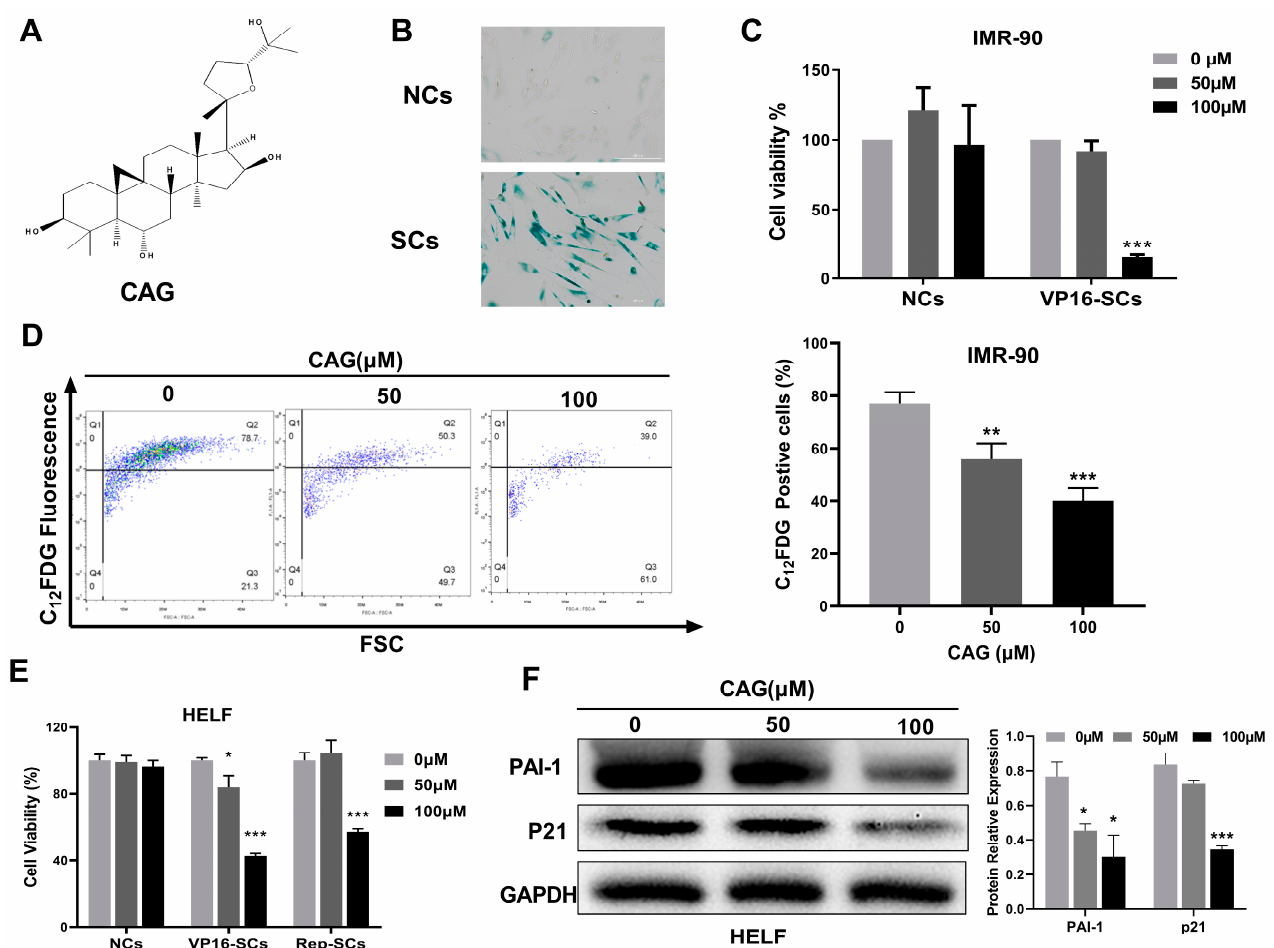
Figure 1. CAG is a potential broad-spectrum senolytic agent. ( A ) Chemical structure of CAG. ( B ) Representative images displaying SA- β -Gal staining after treatment of IMR-90 cells with 20 µM VP-16. Microscopic (magnification of 200 × ) images were taken. ( C ) Survival analysis of nonsenescent (NCs) and senescent IMR-90 cells (VP16-SCs) treated with CAG (at concentrations of 50 and 100 µ M, respectively). ( D ) Representative flow cytometric histogram showing detection of SA- β -Gal activity using C12FDG in SCs after CAG treatment. The line indicates the cut-off in intensity levels used to de fi ne SCs (the cells above the line are SCs). ( E ) Survival analysis of non- senescent (NCs) and senescent HELF cells (VP16-SCs and Rep-SCs) treated with CAG (at concen- trations of 50 and 100 µM, respectively). ( F ) The expression of PAI-1 and P21 in senescent HELF cells after incubation with indicated concentrations of CAG. Protein levels were determined using Western blots. The data were derived from three biological replicates. * p < 0.05, ** p < 0.01, and *** p < 0.001.